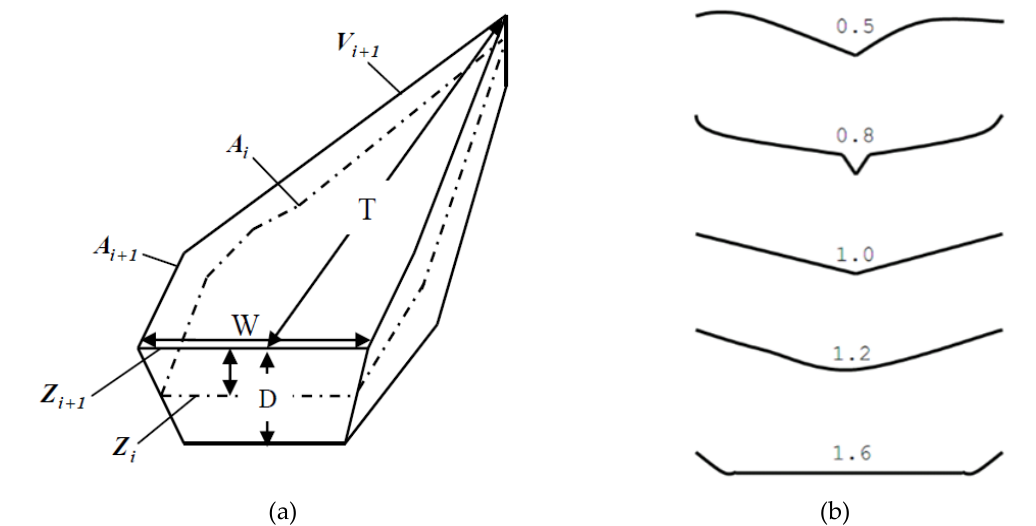
Figure 1. ( a ) Schematic representation of reservoir storage estimation and dimensional parameters; ( b ) Gulley profiles for reservoir definition according to shape k factors (adapted from [7] and [12]).